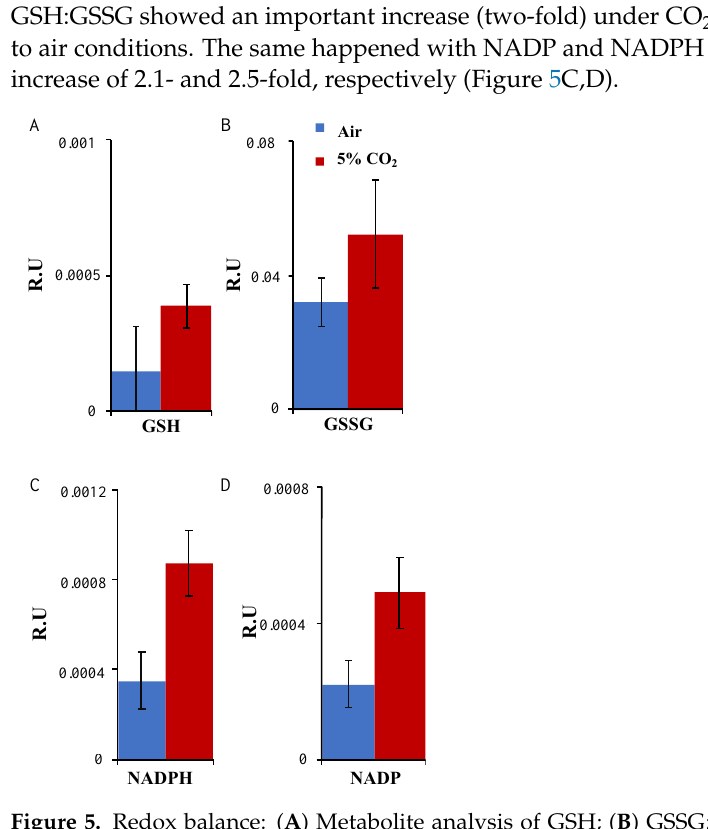
Figure 5. Redox balance: ( A ) Metabolite analysis of GSH; ( B ) GSSG; ( C ) NADPH; ( D ) NADP in Chlorella sorokiniana samples under air and 5% CO 2 . The mean ± SE was calculated and performed in quintuplicate for each condition, and two biological replicates were analyzed as described in the Methods section.